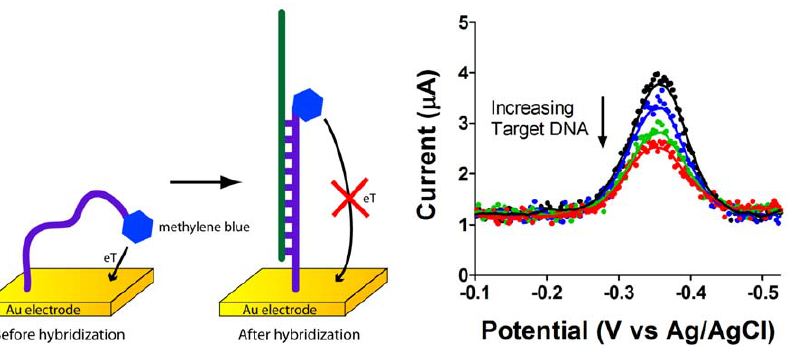
Figure 6. The electrochemical detection of a specific DNA sequence directly in PCR mix. An E-DNA sensor (left) was interrogated via square wave voltammetry. Scanning the E-DNA biosensor at 100 Hz before and after the addition of complimentary target (20, 60, and 200 nM in PCR mix) clearly indicates the presence of the target DNA: over the course of an hour, hybridization with the analyte (at 200 nM) caused a 61% decrease in the peak current.